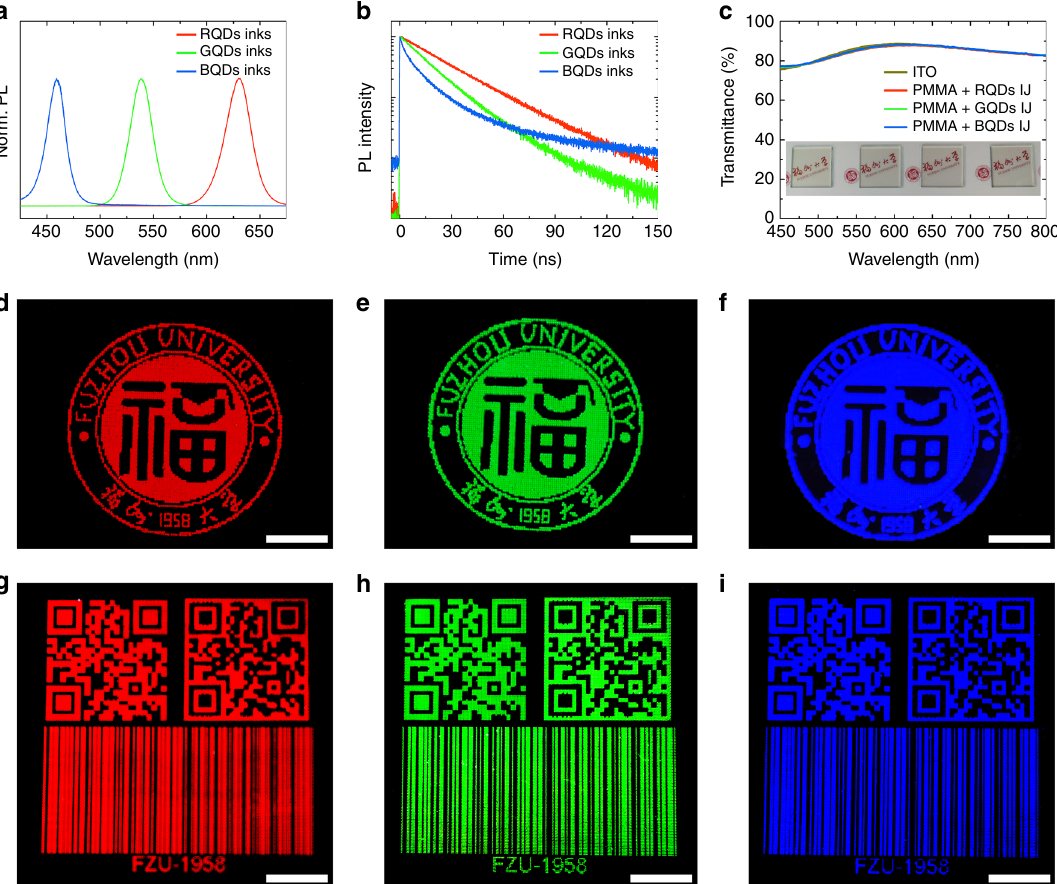
Fig. 2 Optical characterization. a Fluorescence spectra and b time-resolved fl uorescence decay measurements of red, green, and blue emission